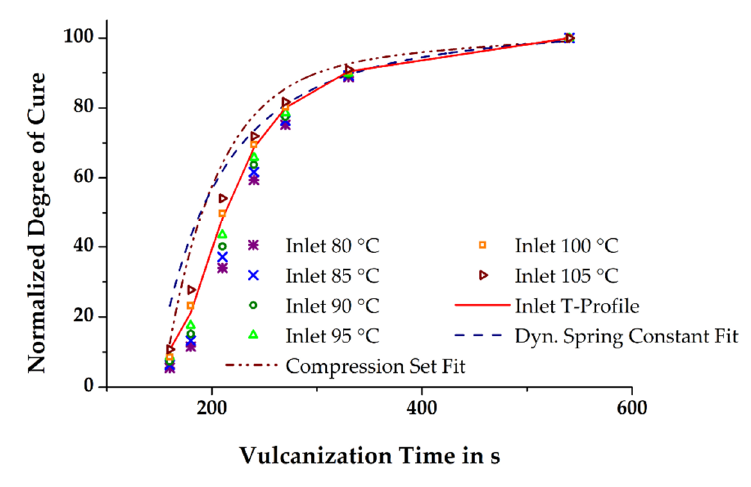
Figure 9. Comparison of the normalized relative degree of cure obtained from simulation and mechanical testing of injection-molded rubber parts.